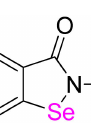
Figure 1. The chemical structure of